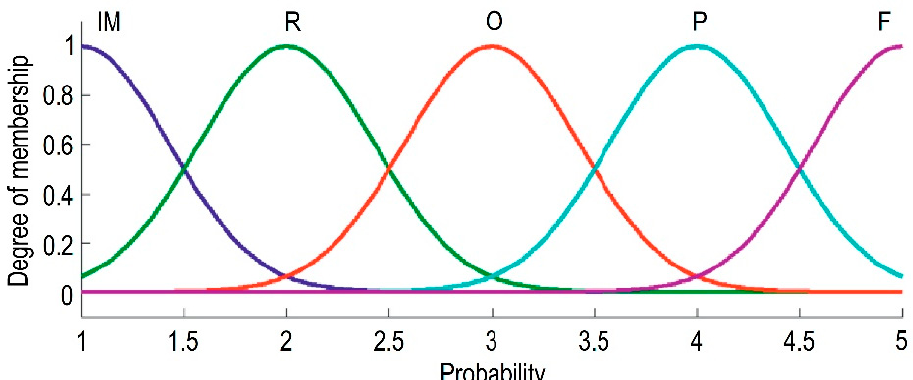
Figure 3. Membership function for the probability level.